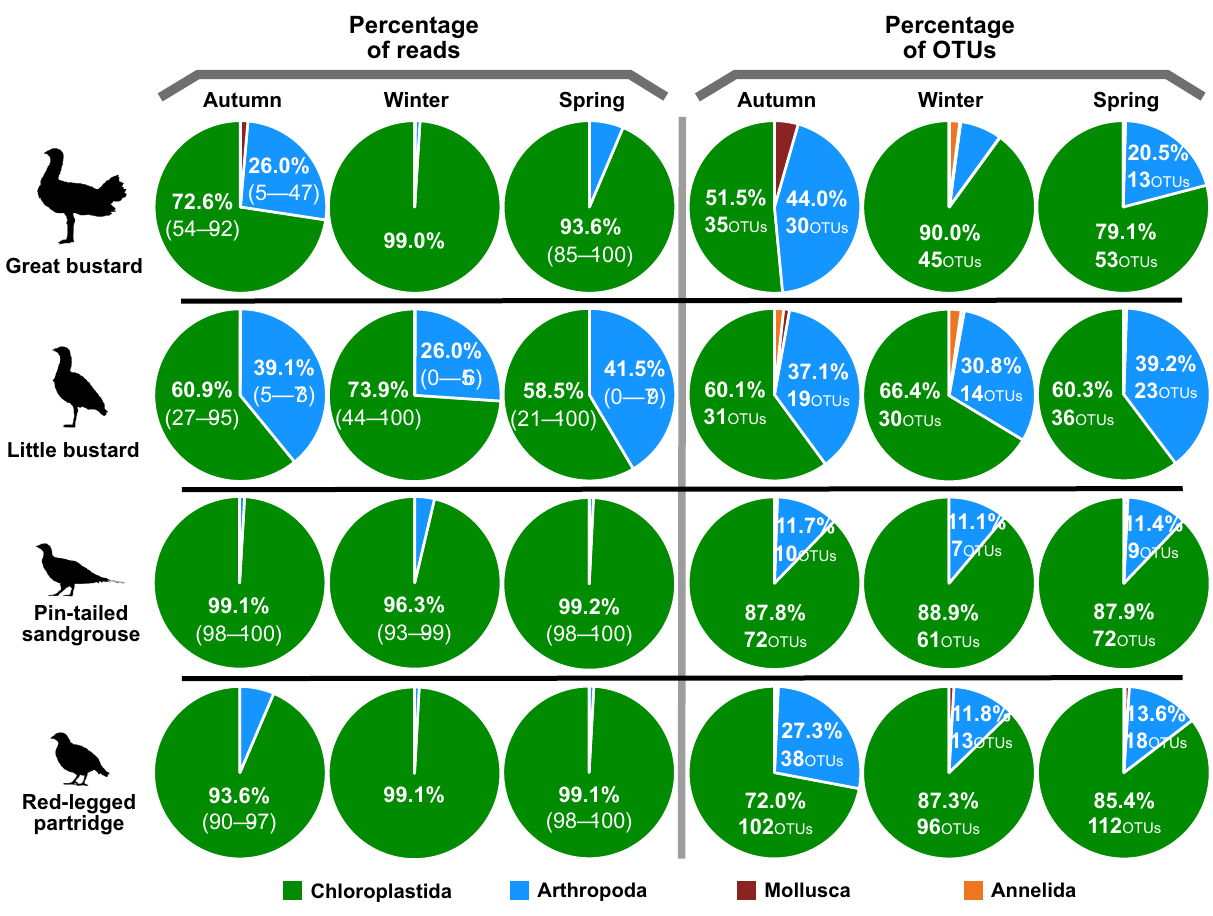
Figure 6. Mean percentage of reads (a measure of abundance) and OTUs (a measure of richness) of the Chloroplastida, Arthropoda, Mollusca, and Annelida taxa present on the diet of great bustard, little bustard, pin-tailed sandgrouse, and red-legged partridge in autumn, winter and spring. Percentages > 10% are detailed numerically and in the case of reads, SD is indicated in brackets. In the OTUs graphs, OTUs richness is also indicated. For great Bustard and red-legged Partridge, only one flock was sampled in winter so no SDs are